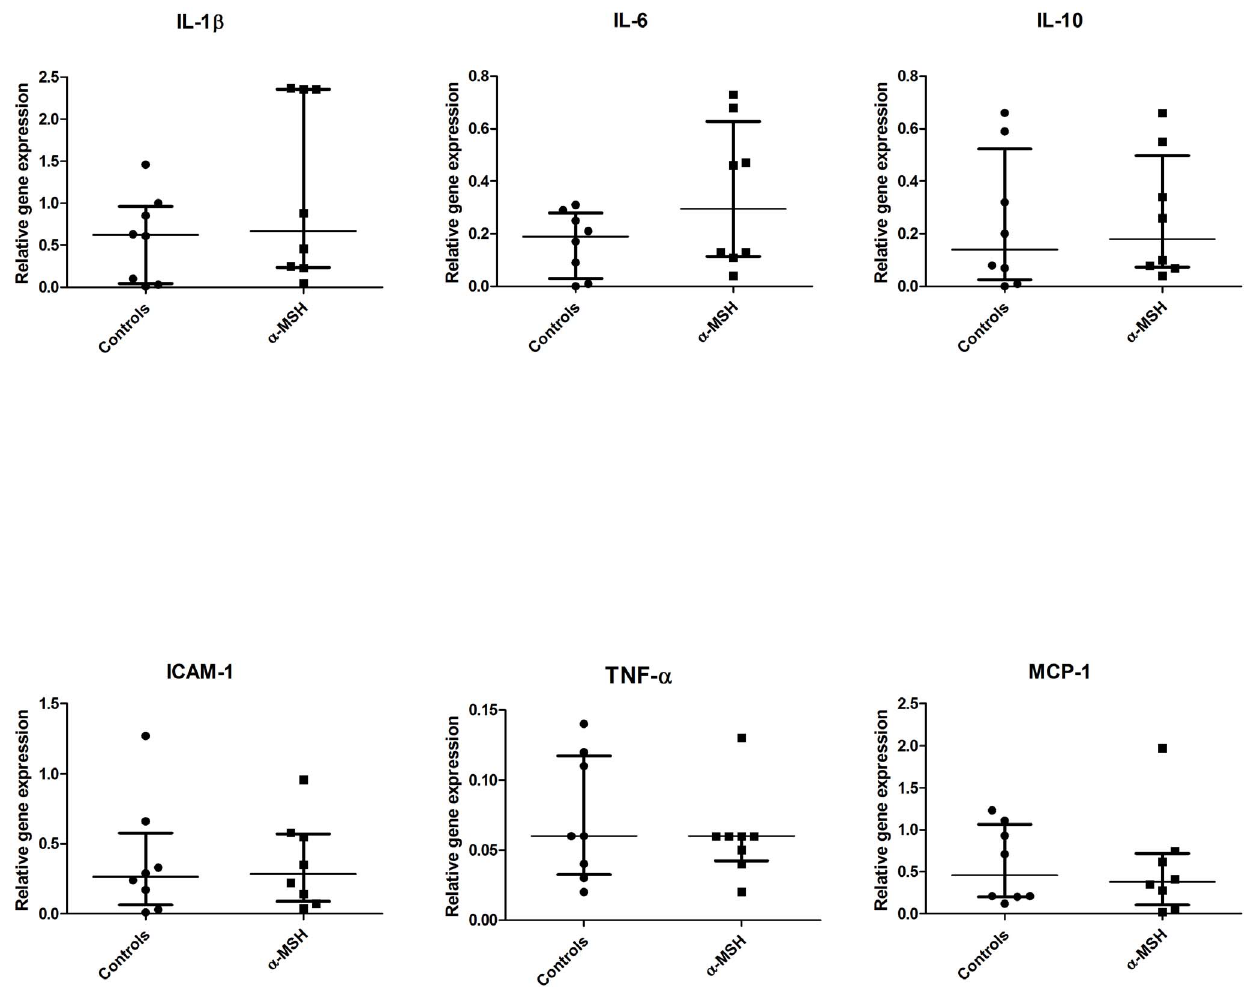
Figure 9. Effect of a -MSH inflammatory markers. a -MSH treatment did not significantly affect mRNA expression of IL-1 b , IL-6, IL-10, ICAM-1, TNF- a or MCP-1.